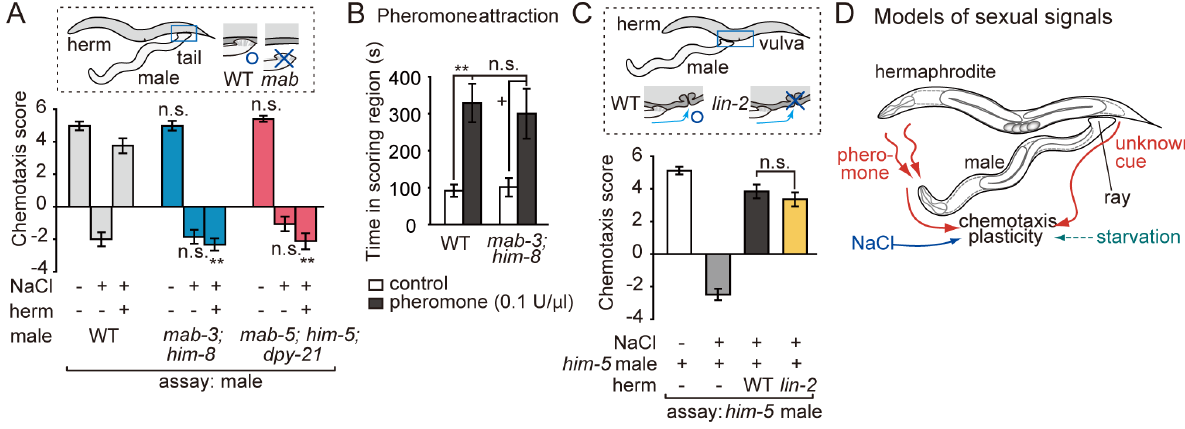
Figure 4. Sexual conditioning requires the male tail function. (A) The mab-3(e1240); him-8(e1489) and mab-5(e1239); him-5(e1490); dpy- 21(e428) males were conditioned with the WT hermaphrodites. The him-5 and him-8 mutations were used to increase the incidence of males. The mab-5(e1239); him-5(e1490); dpy-21(e428) hermaphrodites produce dpy hermaphrodites and non-dpy males. These tail-defective males were defective in sexual conditioning. (B) Pheromone attraction assay (0.1 U/ m l) of the mab-3(e1240); him-5(e1490) mutant. Tail-defective males respond normally to pheromones. (C) The WT males were conditioned with lin-2(e1309) vulvaless hermaphrodites. Vulvaless hermaphrodites can provide the cue for sexual conditioning. (D) Model for the sexual signals transmitted from hermaphrodites to males in sexual conditioning. The hermaphrodite pheromone and another cue are both required for sexual conditioning, and may be detected by the head and tale sensory systems of males, respectively. **, P , 0.001; + , P , 0.05; n.s., not significant. Error bars represent SEM. n=49–69 animals for salt chemotaxis assay, and 16–27 animals for pheromone attraction assay.